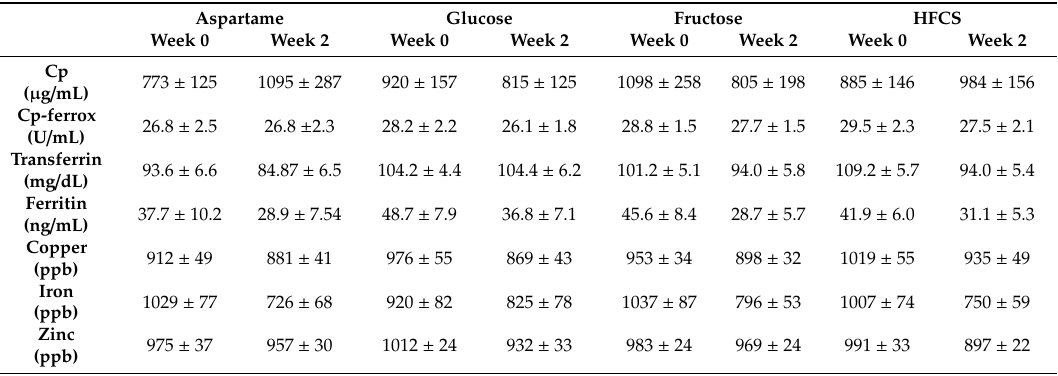
Table 2. Serum metals and metal metabolism markers during consumption of aspartame, glucose, fructose, or HFCS-sweetened beverages at week 0 and week 2. Means ± SEMs are shown.